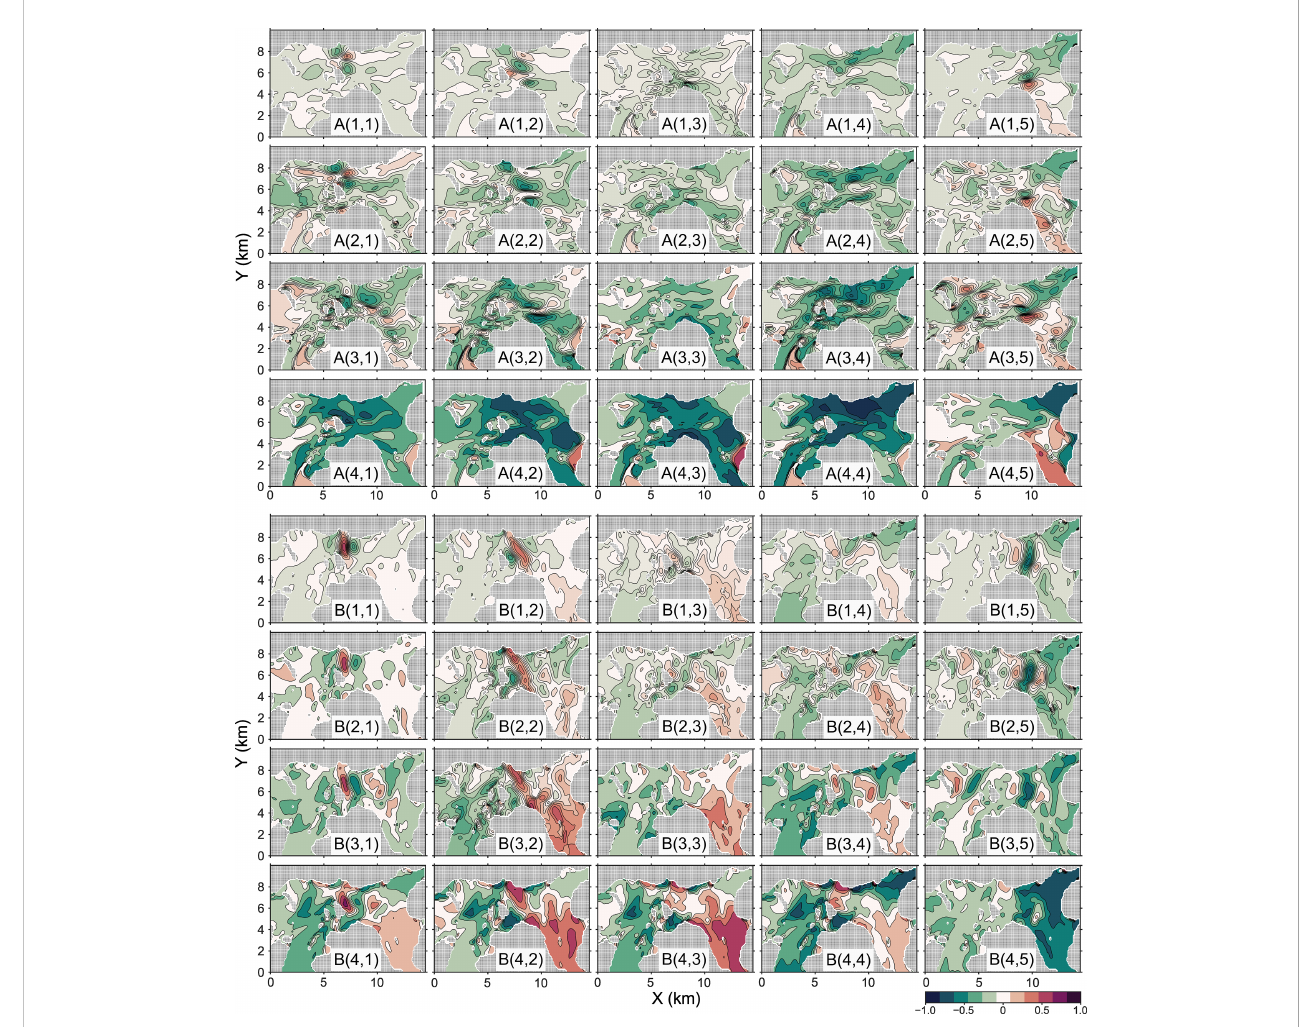
FIGURE 10 Spatial map of ensemble correlation associated with cross-covariance Ẽ k ( H Ẽ k ) T in Eq. (13) for eastward ( U ; panels A ) and northward ( V ; panels B ) components at a speci fi c time of 9:00 on October 31, 2020. In each panel (A, B) , the fi rst, second, and third rows show the results of case 3 with 980, 98, and 42 ensemble members, and the fourth row shows the result of case 4 with 42 ensemble members (see Table 3 for the test case). The column number indicates the station pair of the path-averaged currents: S1S2, S1S3, S2S3, S2S4, and S3S4, from the left to right